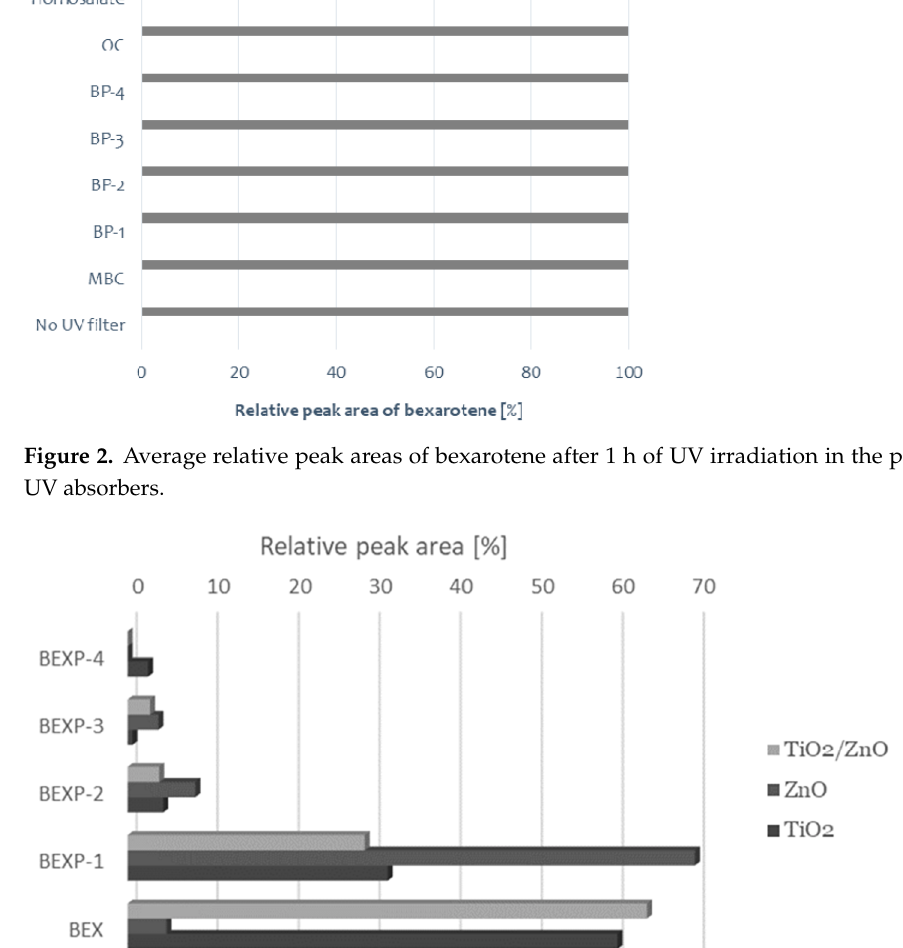
Figure 2. Average relative peak areas of bexarotene after 1 h of UV irradiation in the presence of UV absorbers.